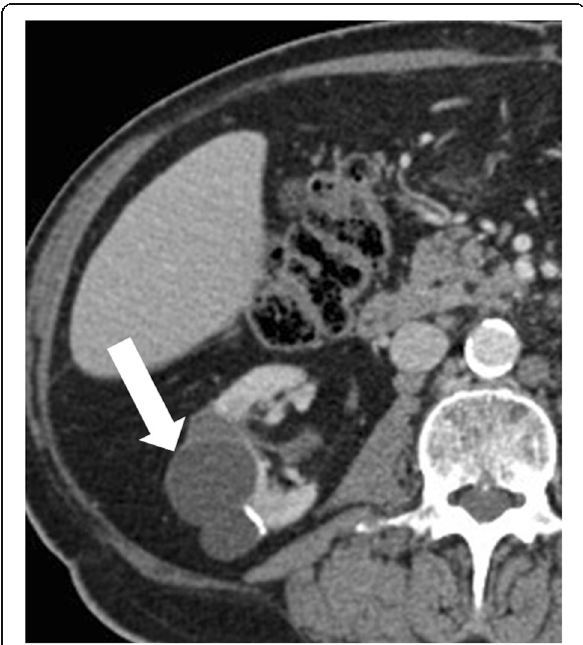
Fig. 13 Localized cystic renal disease. Axial contrast-enhanced CT image shows a conglomeration of multiple simple cysts of variable size (arrow) in the right